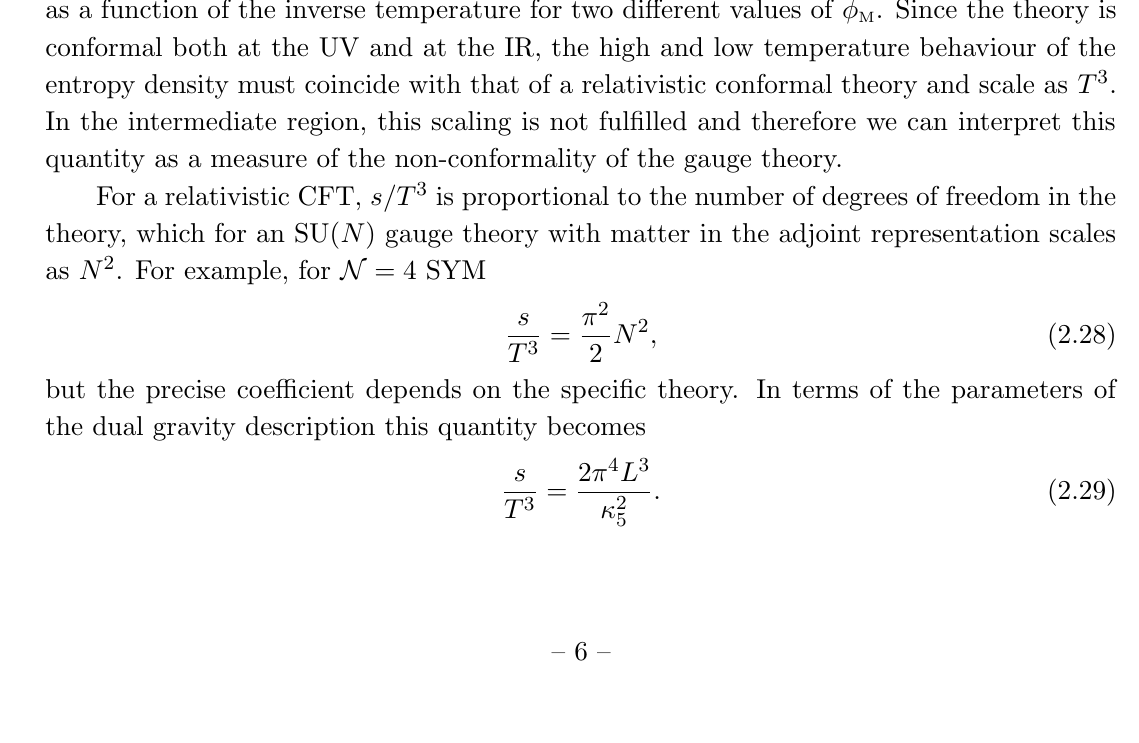
= 3 (left) and (cid:30) = 10 (right) as a M M =L IR